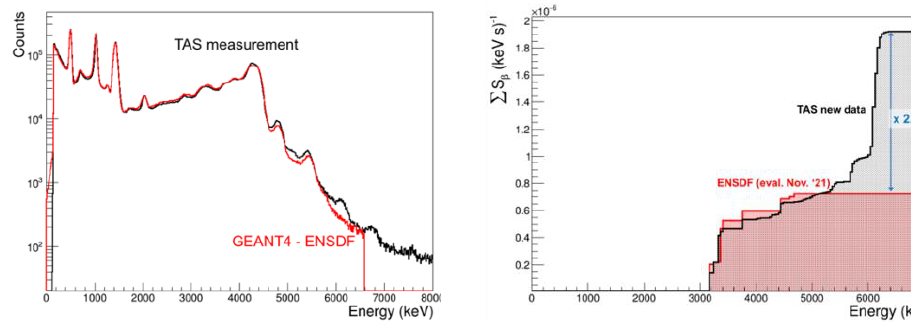
Fig. 2. Left: TAS spectrum of the beta decay of 64 Ga (black) compared to the Geant4 simulation of the same decay in the same detector using ENSDF data (red). Right: beta- strength distribution (integral) of the same decay resulting from the analysis of the TAS data (black) compared to the one from ENSDF